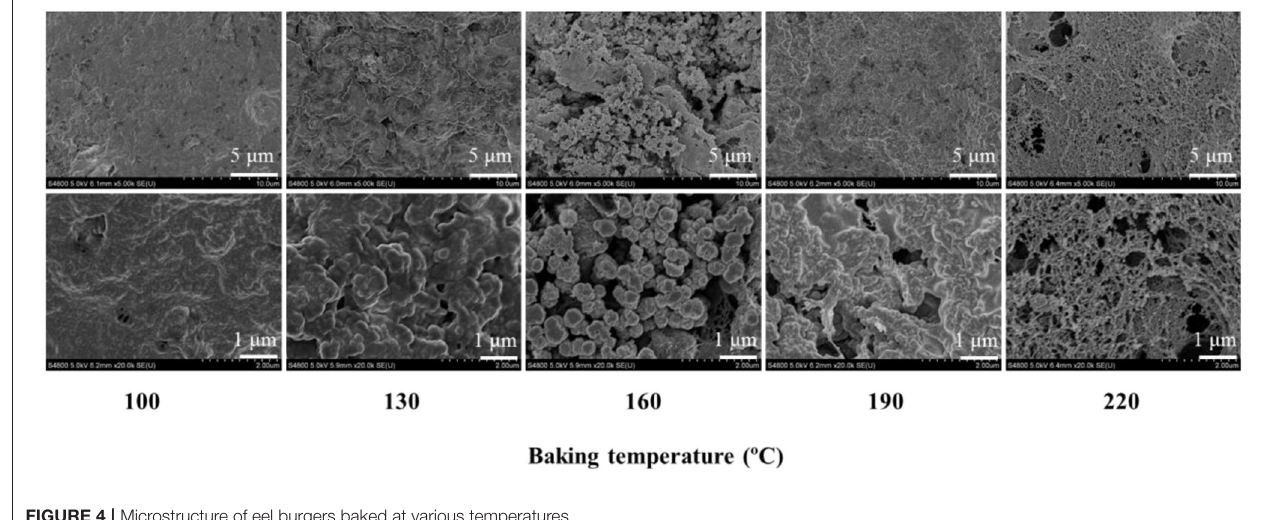
FIGURE 4 | Microstructure of eel burgers baked at various temperatures.